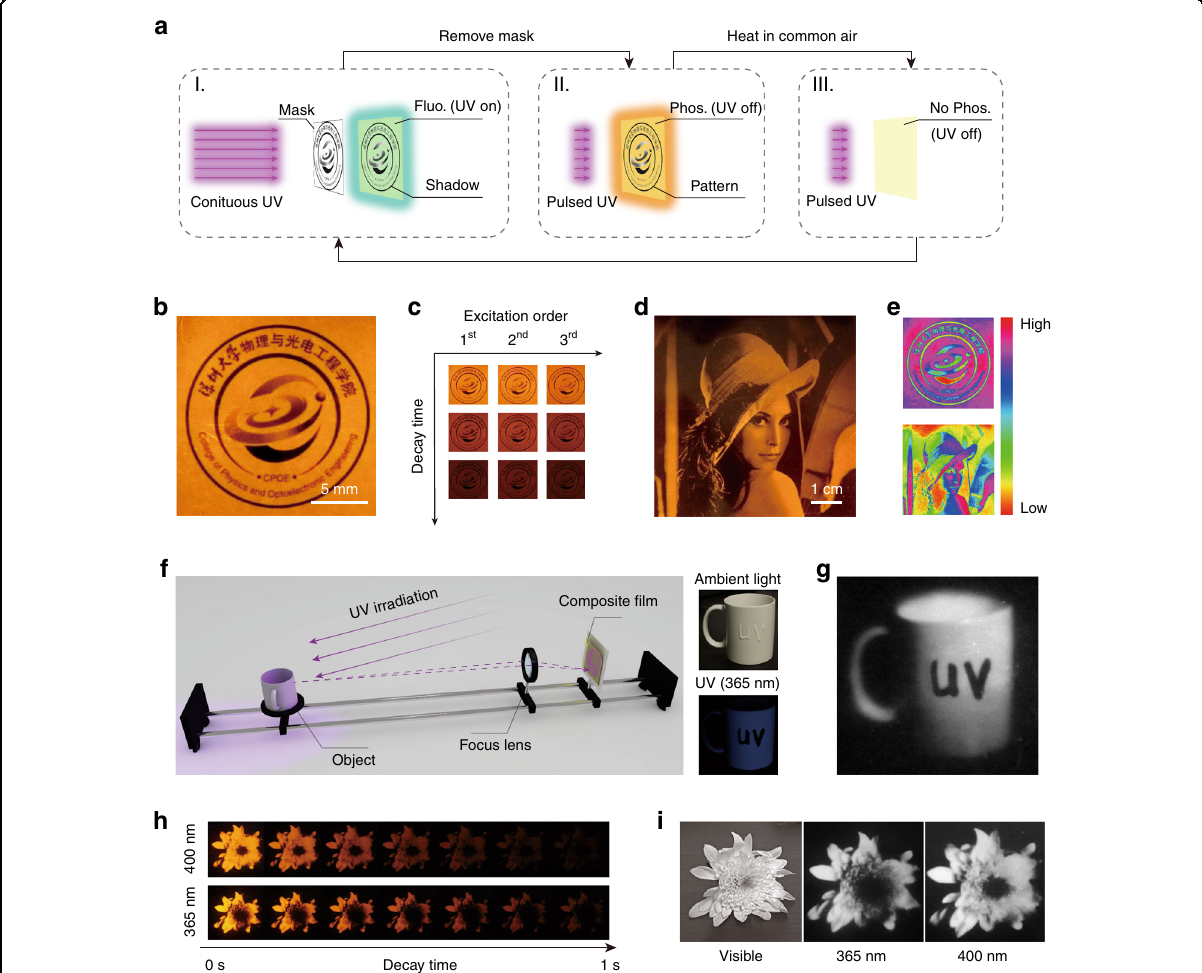
Fig. 4 The processing of halogen-doped CDs composite for grayscale patterning by mask and lens. a Schematic illustration of the photopatterning (I), reproduction (II) and thermal reset (III) procedures of creating grayscale graphs. b Photograph of a grayscale icon created by mask and photolithography. c Photographs of the patterned icon with repeated excitations. d Photograph of a grayscale portrait created by mask and photolithography. e The grayscale distribution of b and d depicted in colored LUT. f Scheme for UV photography with a CDs composite fi lm. g Grayscale UV image (inverted for display) reproduced from the DURTP. h Decay of the DURTP long afterglow patterns of a daisy fl ower captured by UV photography. i Comparison of the grayscale photographs captured in the visible range (using a commercial camera), 365 and 400 nm (captured with composite 3 through a focal